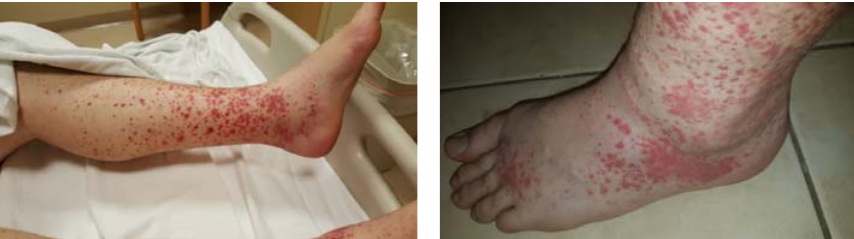
Figure 1: Palpable purpura on the lower extremities with ankle edema and arthritis.